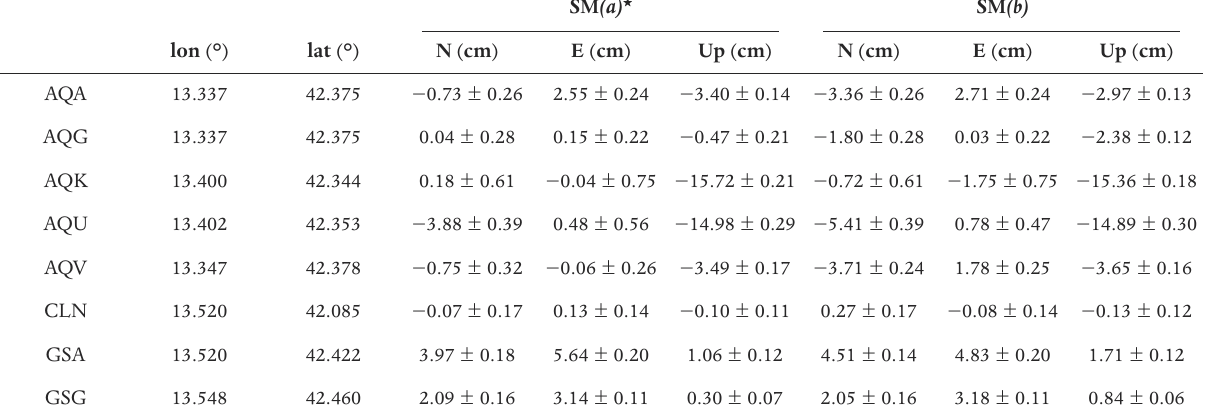
Table 3. Coseismic offsets, for each component, computed at SM stations, using two different displacement time series processing. ( * ) Com- pare to Avallone et al. [2011]: AQG 0.04 ± 0.29, 0.10 ± 0.21, −0.52 ± 0.10; AQK 0.15 ± 0.44, −0.16 ± 1.11, −15.57 ± 0.23; AQU −3.82 ±